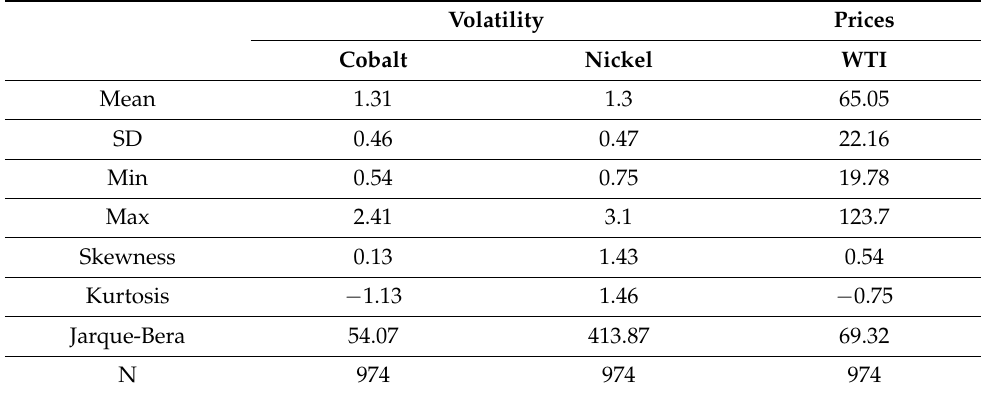
Table 1. The descriptive statistics of the variables of interest in the study over the total dataset.